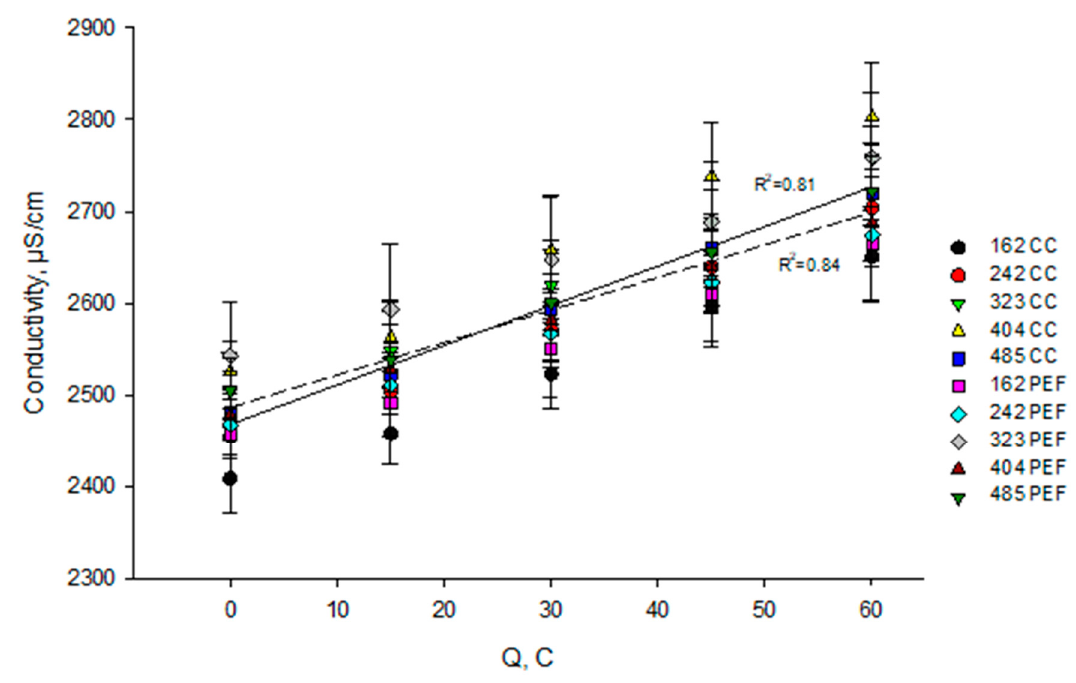
Figure 5. Evolution of KCl compartment conductivity as a function of the number of charges transported (in Coulomb) during EDBM carried out in di ff erent conditions of flow rate (corresponding to indicated Reynolds numbers) and current mode (pulsed electric field (PEF) in dashed line and continuous current (CC) in solid line). Reynolds numbers of 162, 242, 323, 404, and 485 correspond to flow rates of 400, 600, 800, 1000, and 1200 mL / min respectively. CC—constant current and PEF—pulsed electric